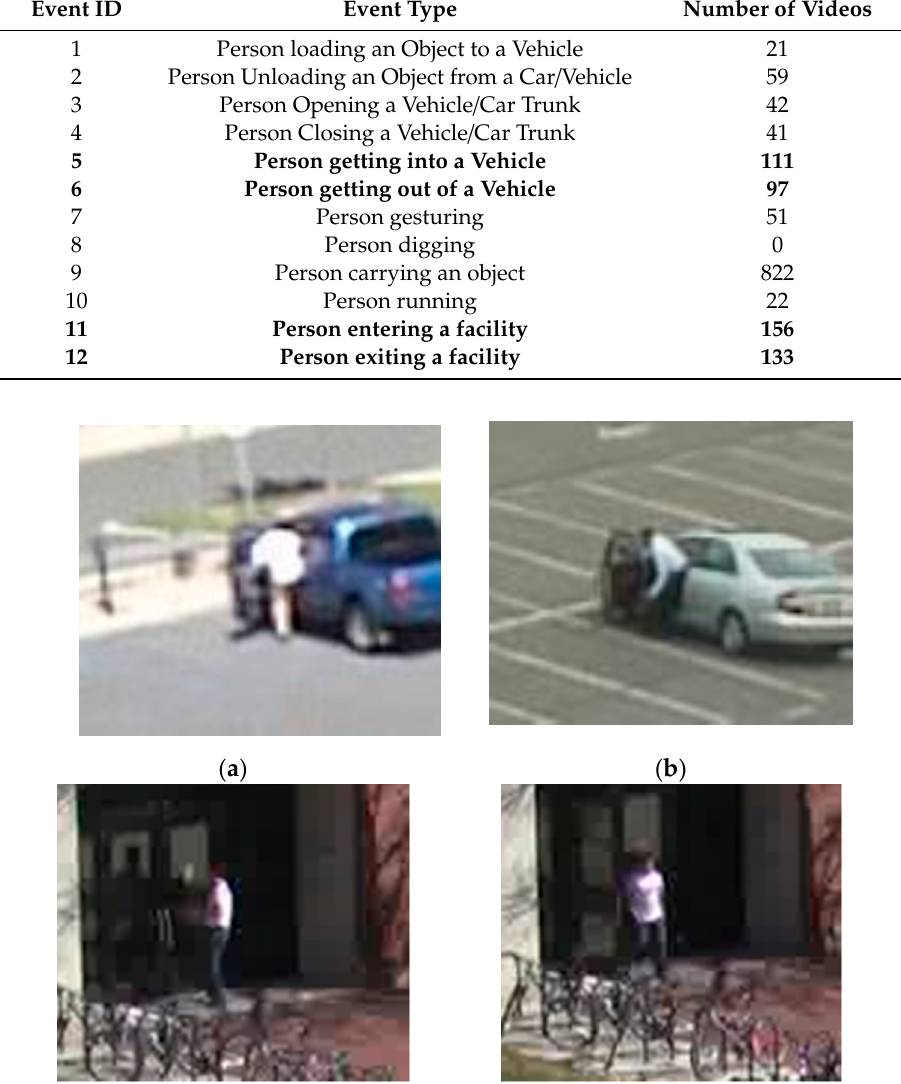
Table 1. The VIRAT 2.0 Dataset main events and the number of videos for each event. The bold letters indicate events of interest in this paper. There are 12 events in total in the VIRAT dataset. Bold characters indicate the events of interest in this paper.